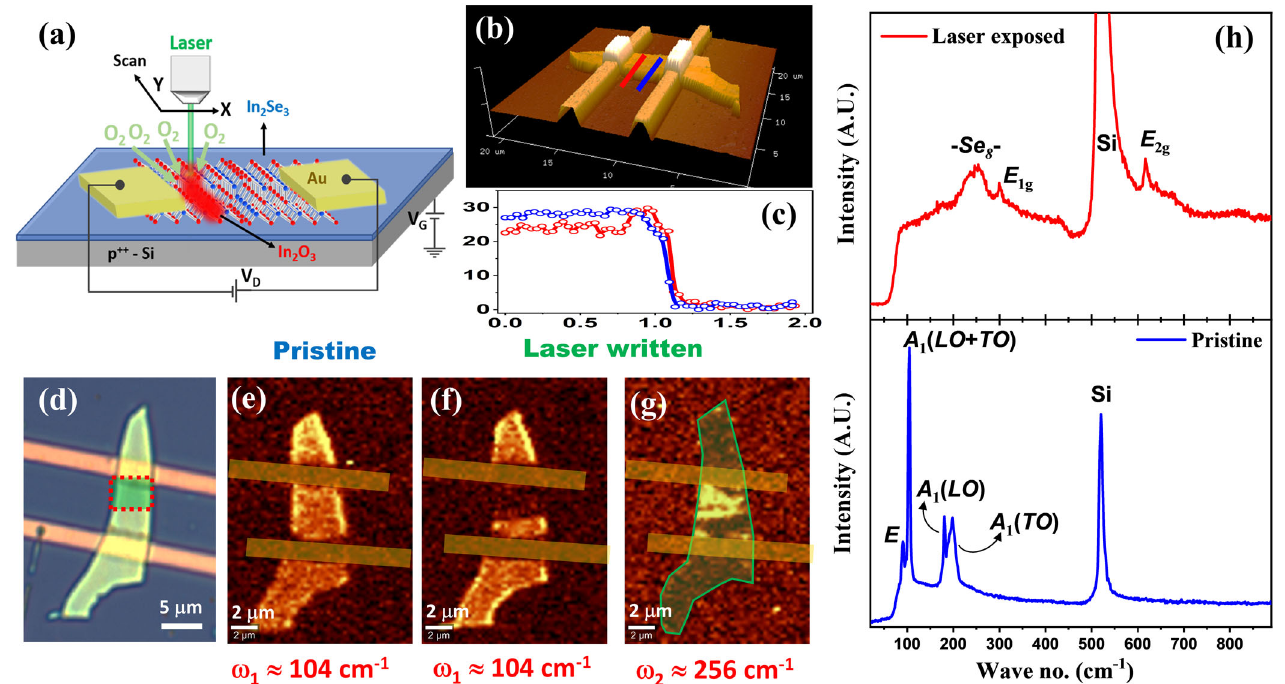
Fig. 1 Materials and device characterizations. a Schematic illustration of the HJ device fabrication process. The external electrical circuit is presented for forward bias and positive gate conditions. b 3D surface topography of the α -In 2 Se 3 /In 2 O 3 HJ FET device measured by AFM. c The fl ake thickness is found to be ~28 nm, as present in the line pro fi le. After laser treatment, ~4 – 5 nm thickness reduction with a slight increase in roughness was observed. d Optical image of the fabricated device (scale bar 5 μ m). The red dotted area is indicating the selectively laser exposed region. e – g Raman maps for the same device before and after laser expose (scale bar 2 μ m). The electrodes are superimposed for better understating. h Raman spectra are presented for the pristine (blue) and laser written (red)